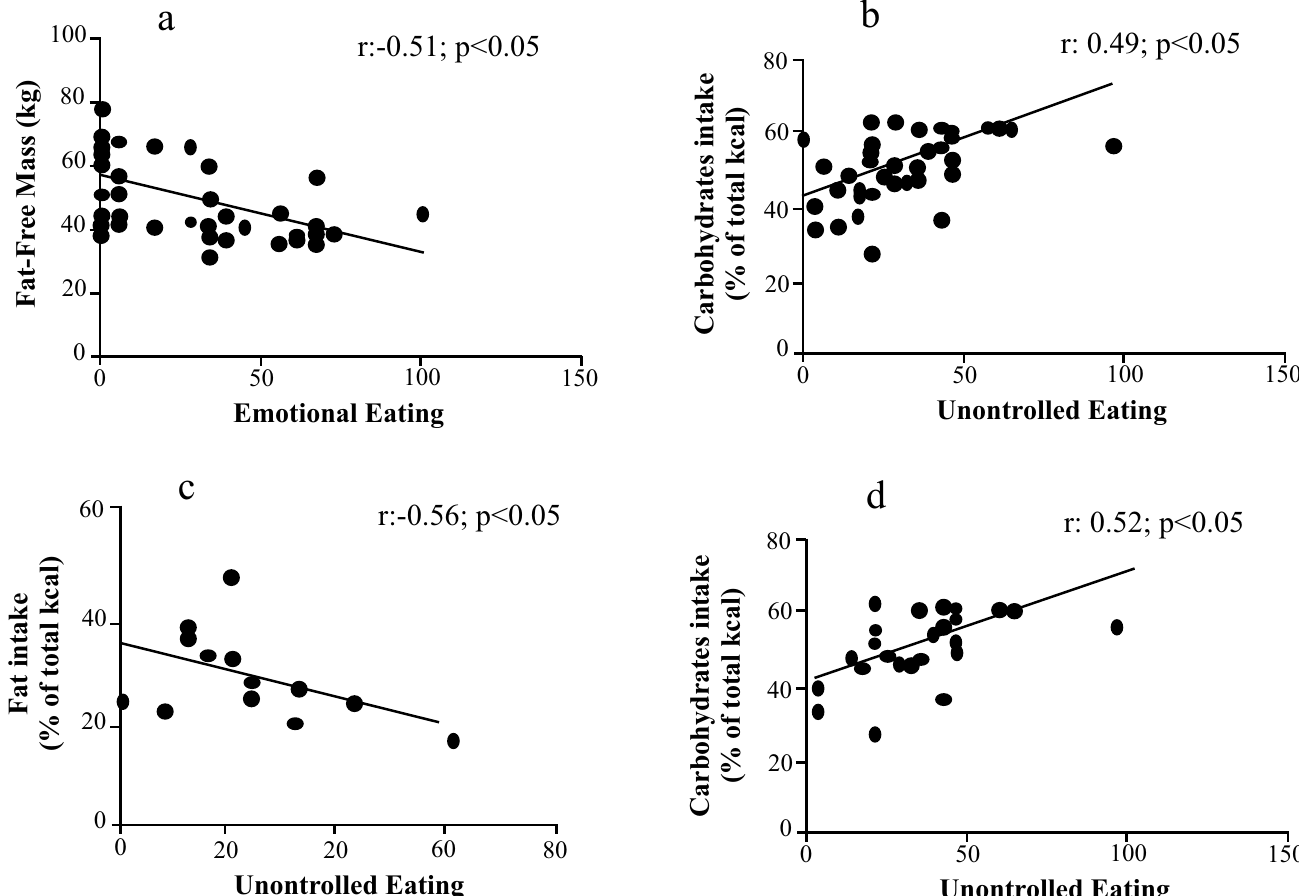
Figure 2. Pearson correlations between eating behaviors components and parameters of body composition and macronutrient intake. (a, b) Significant correlations in all participants; (c) Significant correlation in male participants; (d) Significant correlation in women participants.